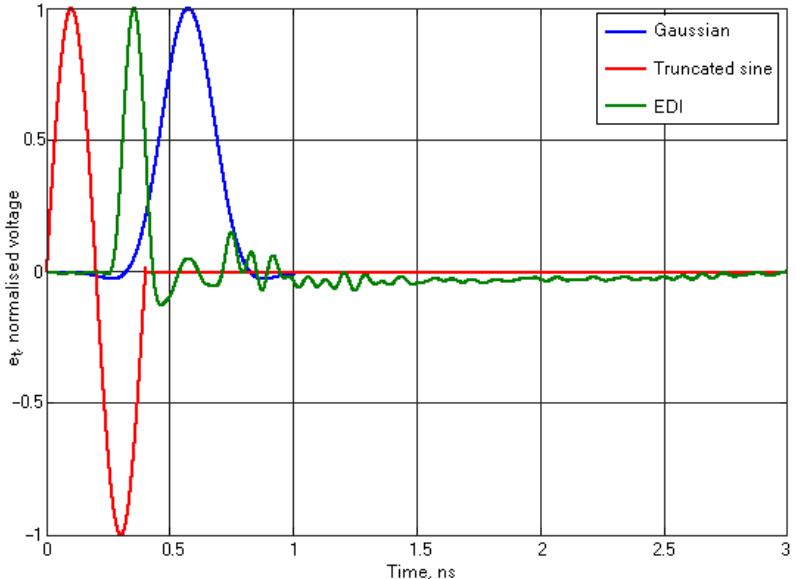
Figure 5. Normalized signals used in simulations: (a) blue line—Gaussian signal SetGaussEx- cite ( FDTD , 1e9, 2.5e9 ); (b) red line—truncated sine signal; (c) green line—Signal of EDI